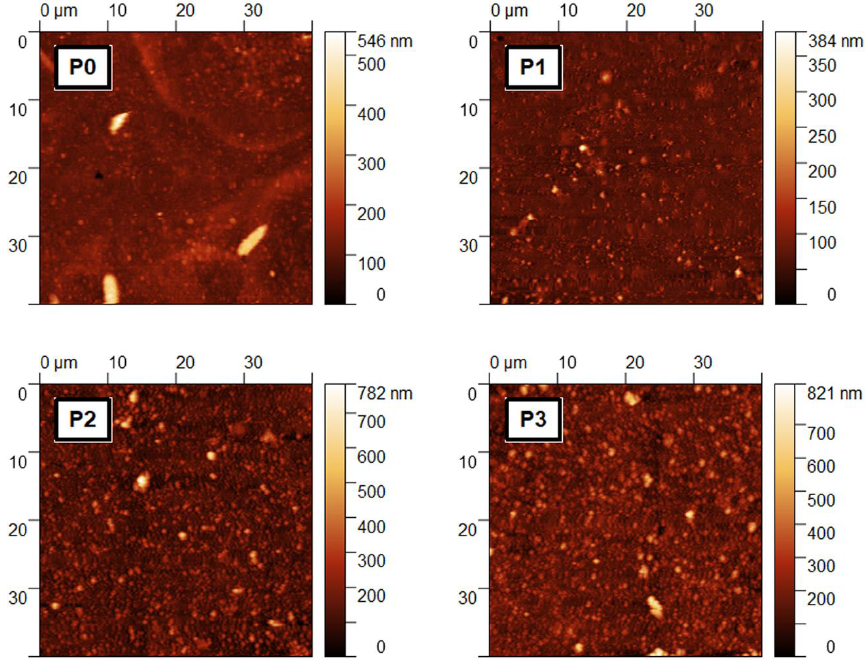
Figure 6. Topographic images of the MAPLE-deposited thin films.